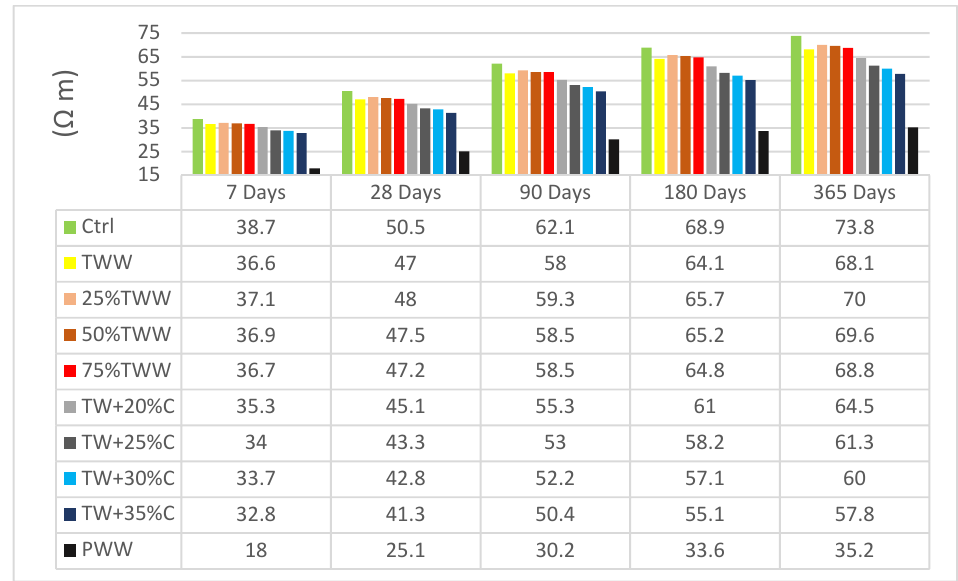
Figure 5. The results of concrete electrical resistivity tests cured by standard water.